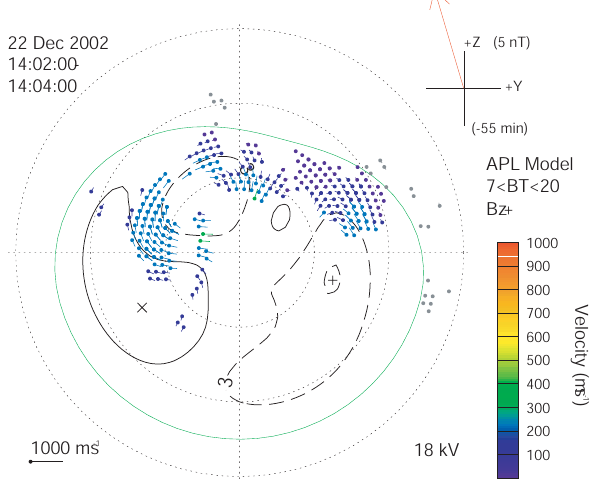
Fig. 12. The Northern Hemisphere map-potential flow vectors and equipotential flow streamlines observed between 14:02 and 14:04 UT (interval